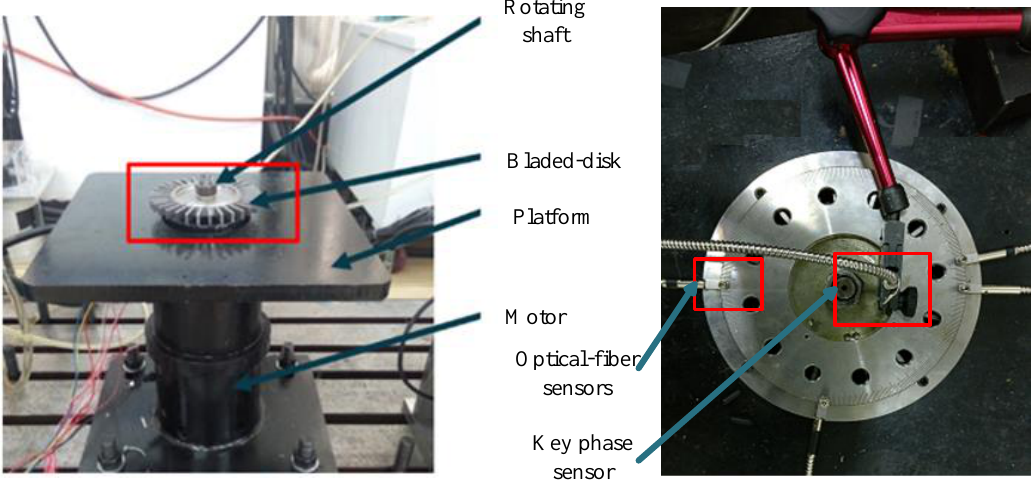
Figure 12. The test rig.